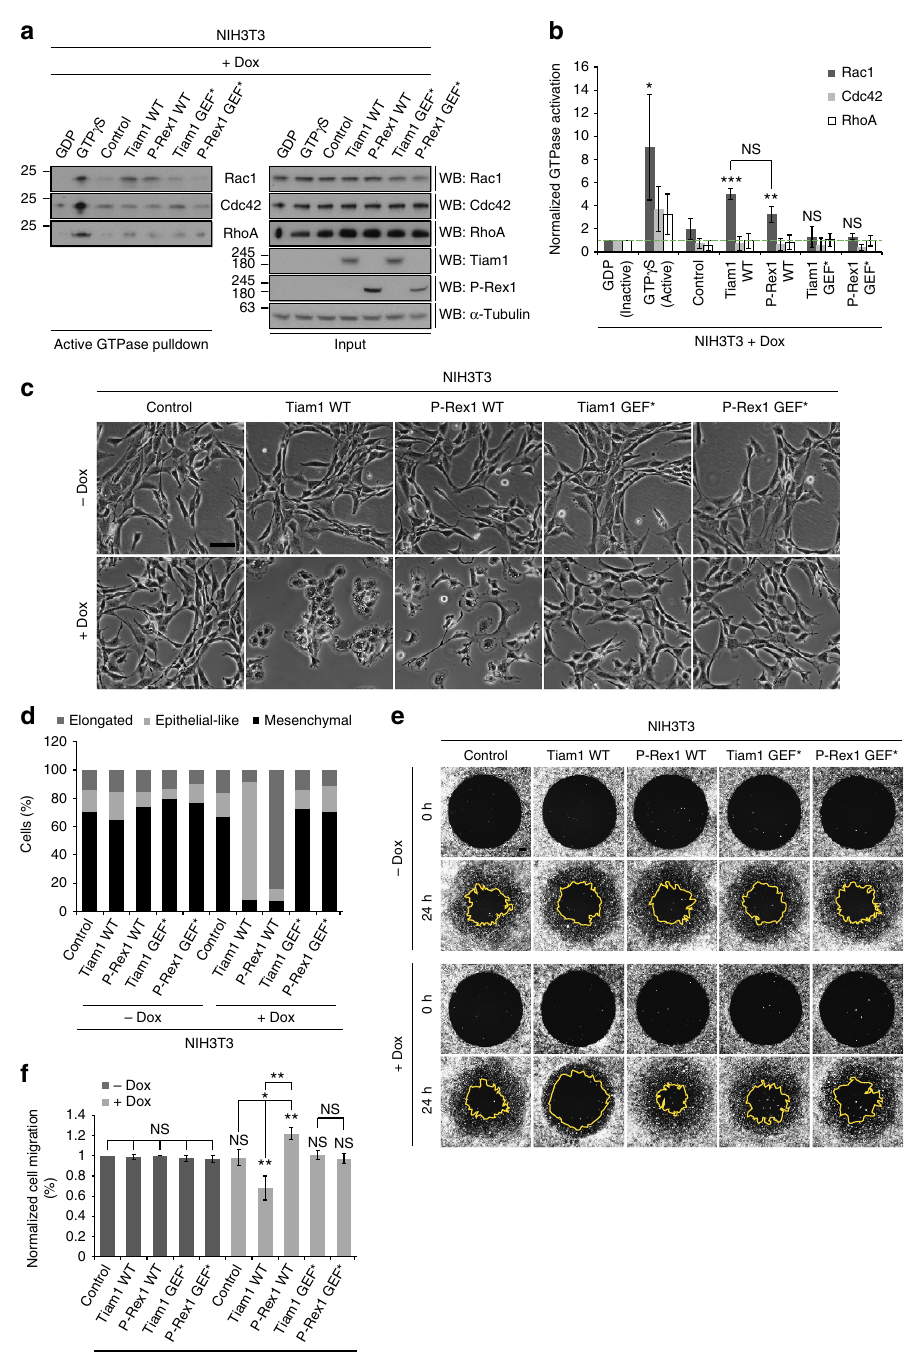
Figure 1 | Activation of Rac1 by Tiam1 or P-Rex1 induces differential effects in NIH3T3 cells. ( a ) Lysates from NIH3T3 cells following 1 m gml (cid:2) 1 doxycycline (dox) treatment for 24h to induce expression of indicated GEF constructs were divided equally and subjected to PAK-CRIB pulldown or Rhotekin pulldown. Levels of active and total Rac1, Cdc42 and RhoA were detected by western blot analysis. GDP and GTP g S loaded NIH3T3 lysates were used as negative and positive pulldown controls, respectively. a -Tubulin was used as a loading control. ( b ) Quantification of levels of active Rac1, Cdc42 and RhoA in NIH3T3 cells described in a relative to total levels of the respective proteins normalized to GDP-loaded NIH3T3 lysates ± s.e.m. from three independent experiments. The dashed green line indicates basal levels of active GTPases in the GDP control. ( c ) Representative phase-contrast images of NIH3T3 cells treated with ethanol ( (cid:2) dox) or 1 m gml (cid:2) 1 dox ( þ dox) for 24h to induce expression of indicated GEF constructs. Scale bar, 100 m m. ( d ) Quantification of GEF-induced cellular phenotypes depicted in c . Graph represents per cent cells with the indicated morphology from a total of 150 cells per condition from three independent experiments. ( e ) Representative fluorescence images following Oris migration assay of NIH3T3 cells treated with ethanol ( (cid:2) dox) or 1 m gml (cid:2) 1 dox ( þ dox) for 24h to induce expression of indicated GEF constructs. Scale bar, 200 m m. ( f ) Quantification of cell migration of NIH3T3 cells described in e normalized to (cid:2) dox treated control cells. Graph represents the average per cent migration ± s.e.m from three independent experiments. In b , f , student’s t -test was used to assess significance as indicated on graphs. P values indicated above each bar are relative to GDP ( b ) or (cid:2) dox treated control cells ( f ). NS, non-significant; * ¼ P r 0.05; ** ¼ P r 0.01; *** ¼ P r